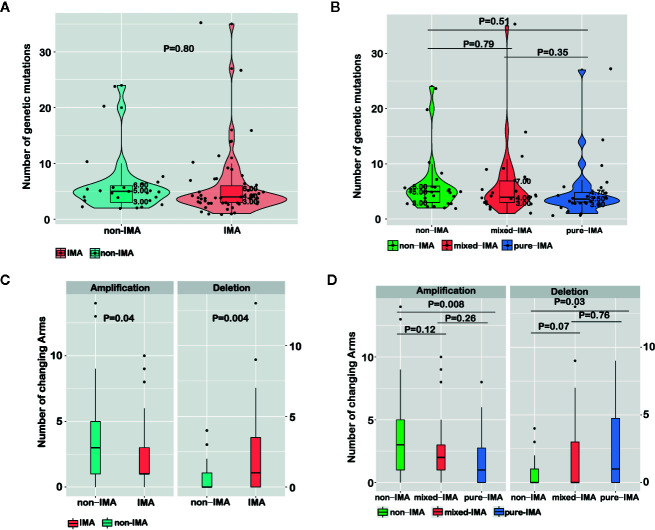
Comparing molecular features among samples with different mucinous contents. The number of genetic mutations for invasive mucinous adenocarcinoma (IMA) vs. non-IMA patients (A) or for patients that were divided based on the mucinous content (B) was shown in violin plots. The number of chromosome arm-level somatic CNVs (SCNVs) for IMA vs. non-IMA patients (C) or for patients that were divided based on the mucinous content (D) was shown in bar graphs.